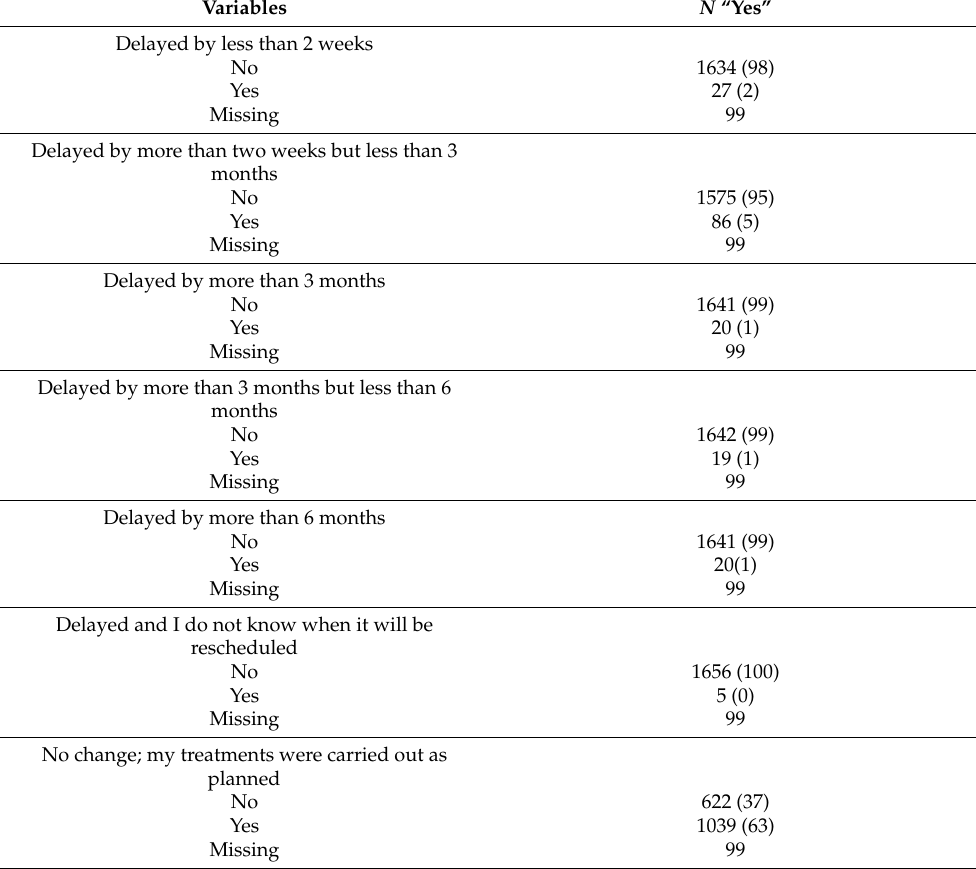
Table 2. Treatment Impact of